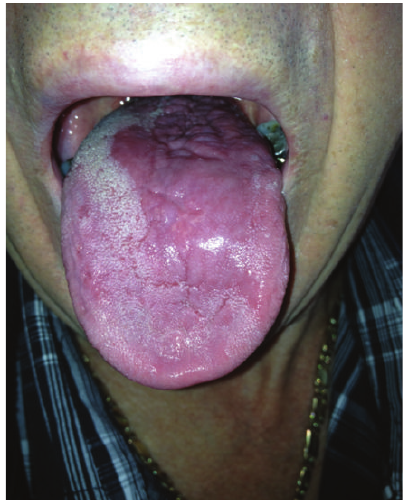
Figure 3: Three months after